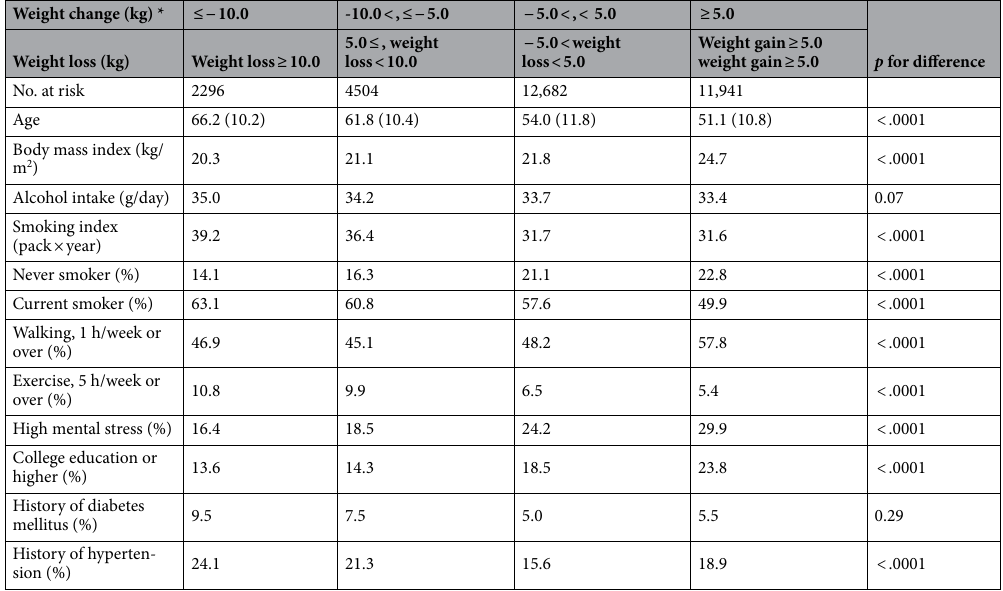
Table 3. Participants’ age-adjusted baseline demographics according to weight change from the age of 20.